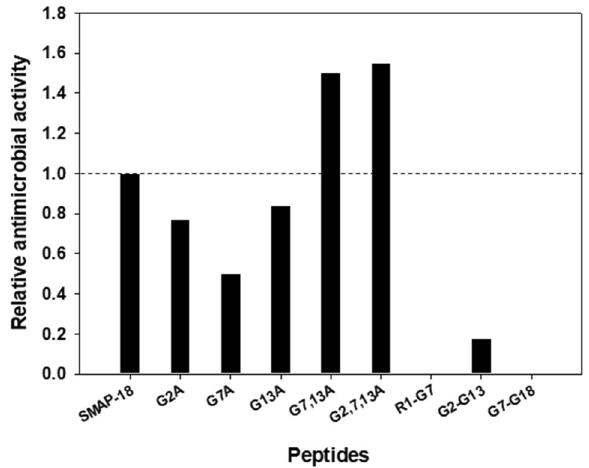
Figure 2. Relative antimicrobial activity of SMAP-18 analogs compared to wild-type SMAP-18 produced based on Table 1.